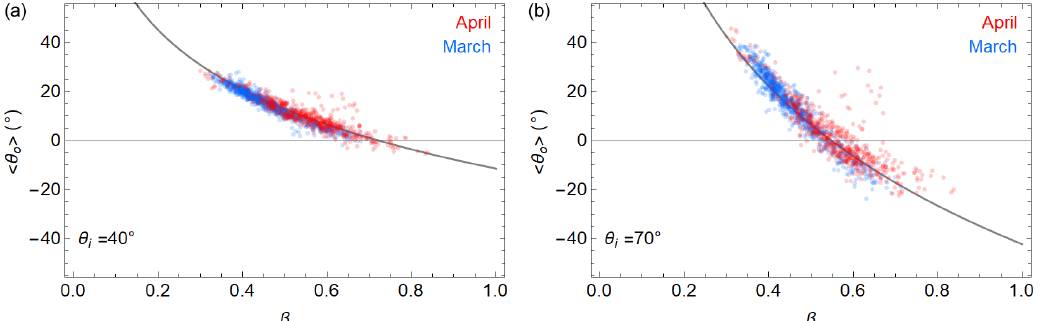
Figure 6. The average zenith angle θ o of the reflected escaping individual ray as a function of the rms slope angle β (in radians) for two irradiance solar zenith angle values θ i for the snow profiles measured in the SNORTEX campaign (Manninen and Roujean, 2014; Anttila et al., 2014) in March and April 2009. The sign of the zenith angle is positive for forward reflection and negative for backward